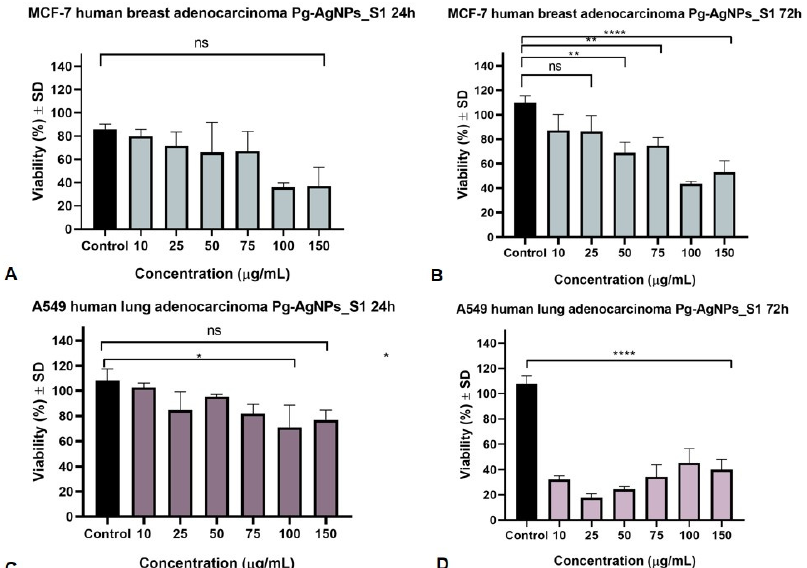
Figure 5. MCF7 and A549 cells viability after 24 and 72 h stimulation with Pg-AgNPs_S1 (10, 25, 50, 75, 100 and 150 µg/mL), ( A )—24 h treatment of MCF7 cells; ( B )—72 h treatment of MCF7 cells; ( C )—24 h treatment of A549 cells; ( D )—72 h treatment of A549 cells. The results are expressed as cell viability percentage (%) related to the Control cells. Comparison among groups was made using tical significance (* p ≤ 0.05; ** p ≤ 0.01; **** p ≤ 0.0001).